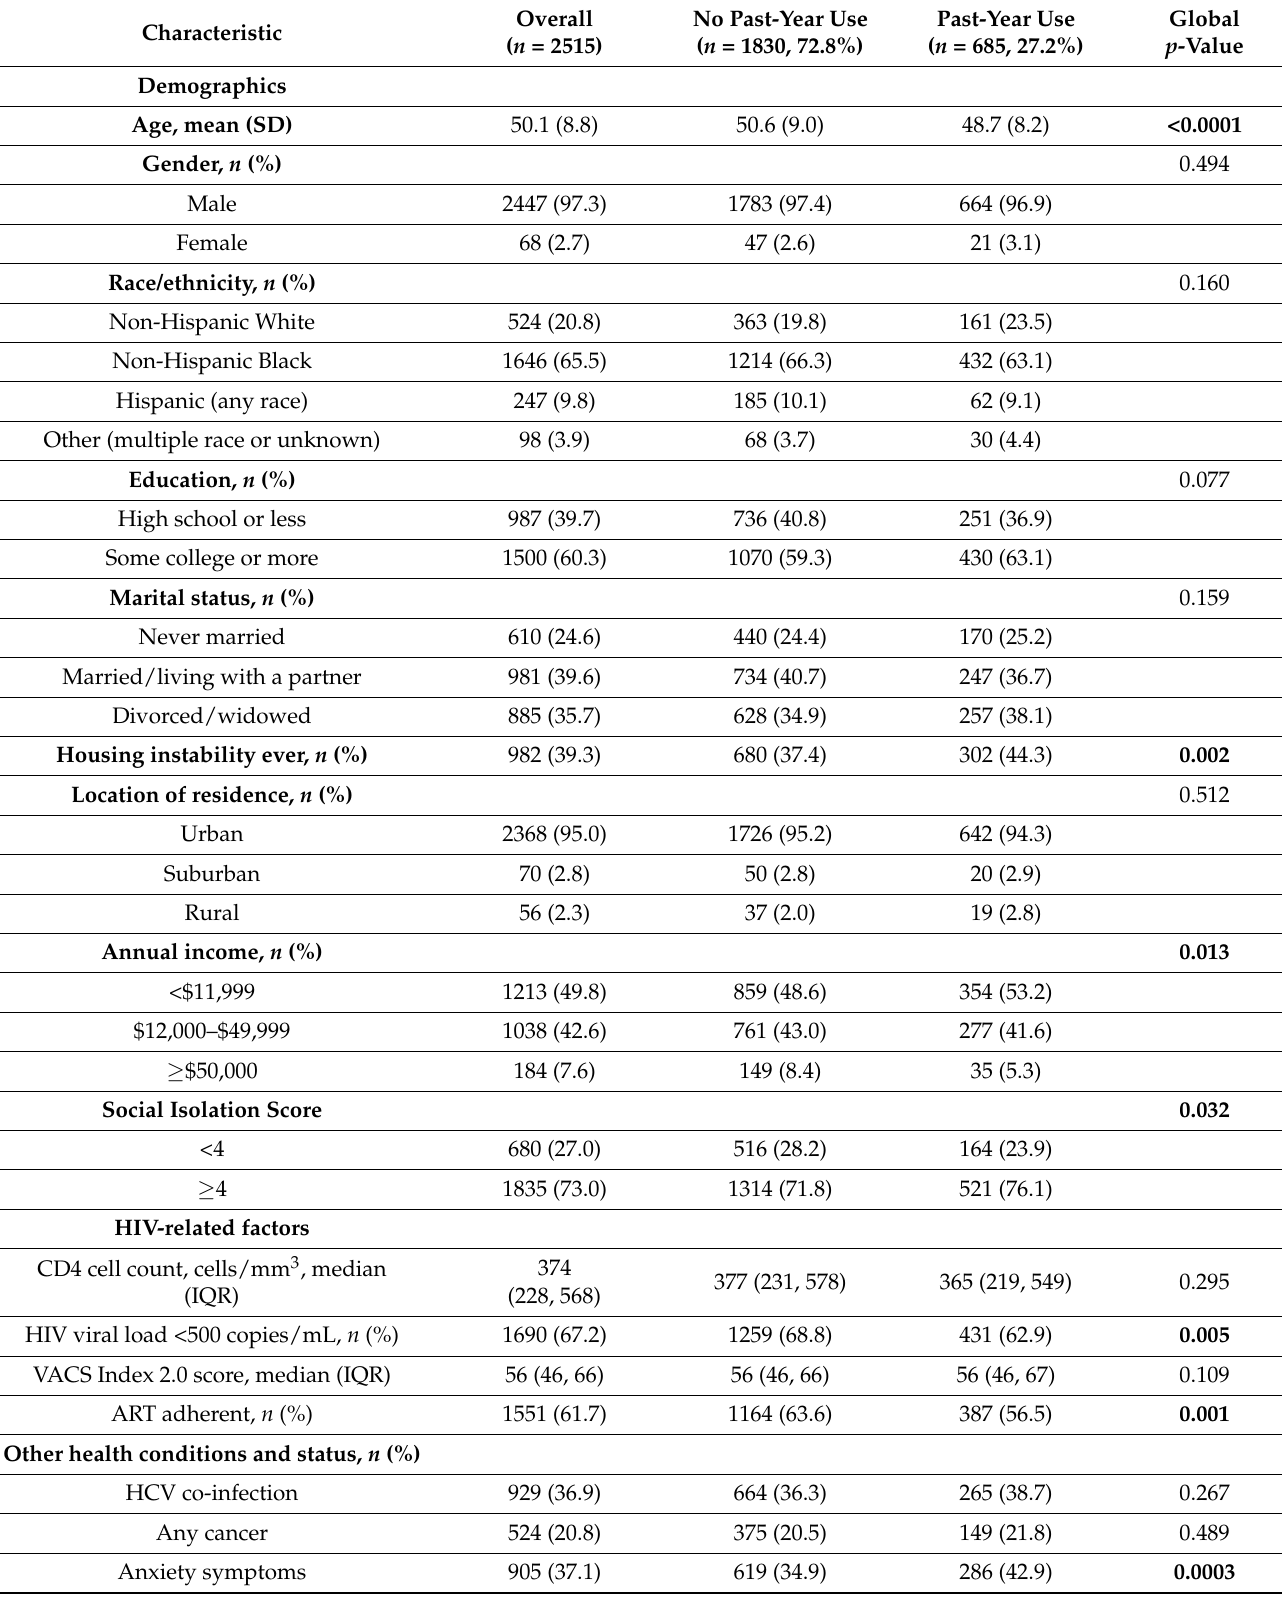
Table 1. Baseline sociodemographic and clinical characteristics associated with cannabis use cate- gories among people living with HIV receiving antiretroviral therapy in the VACS cohort